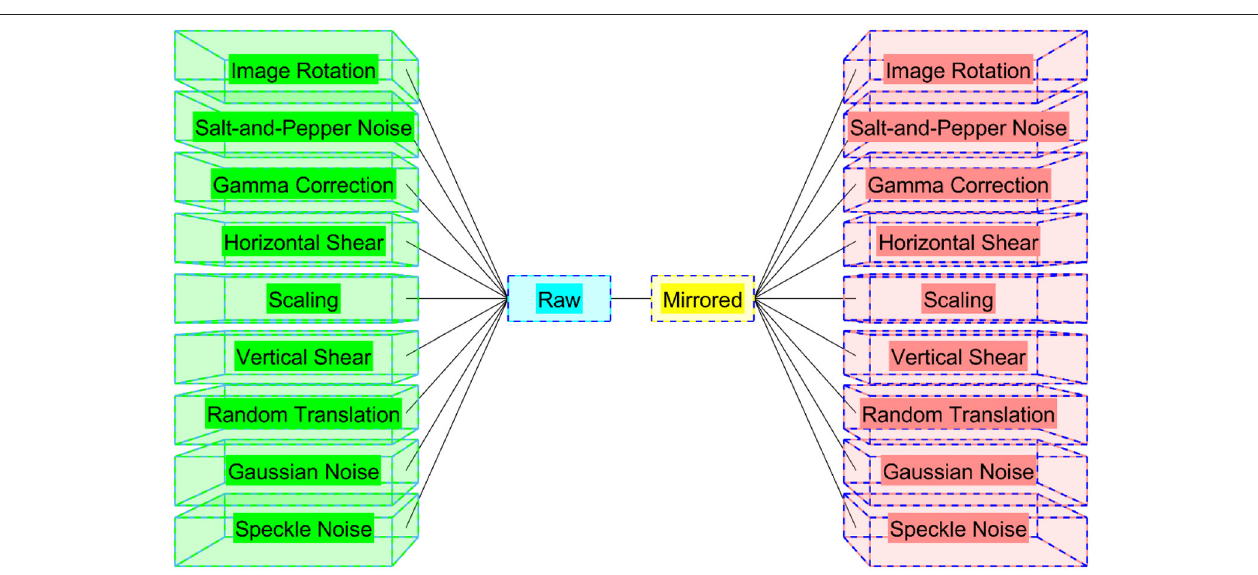
FIGURE 10 | Diagram of 18-way data augmentation (DA) ( R 1 = 9 )